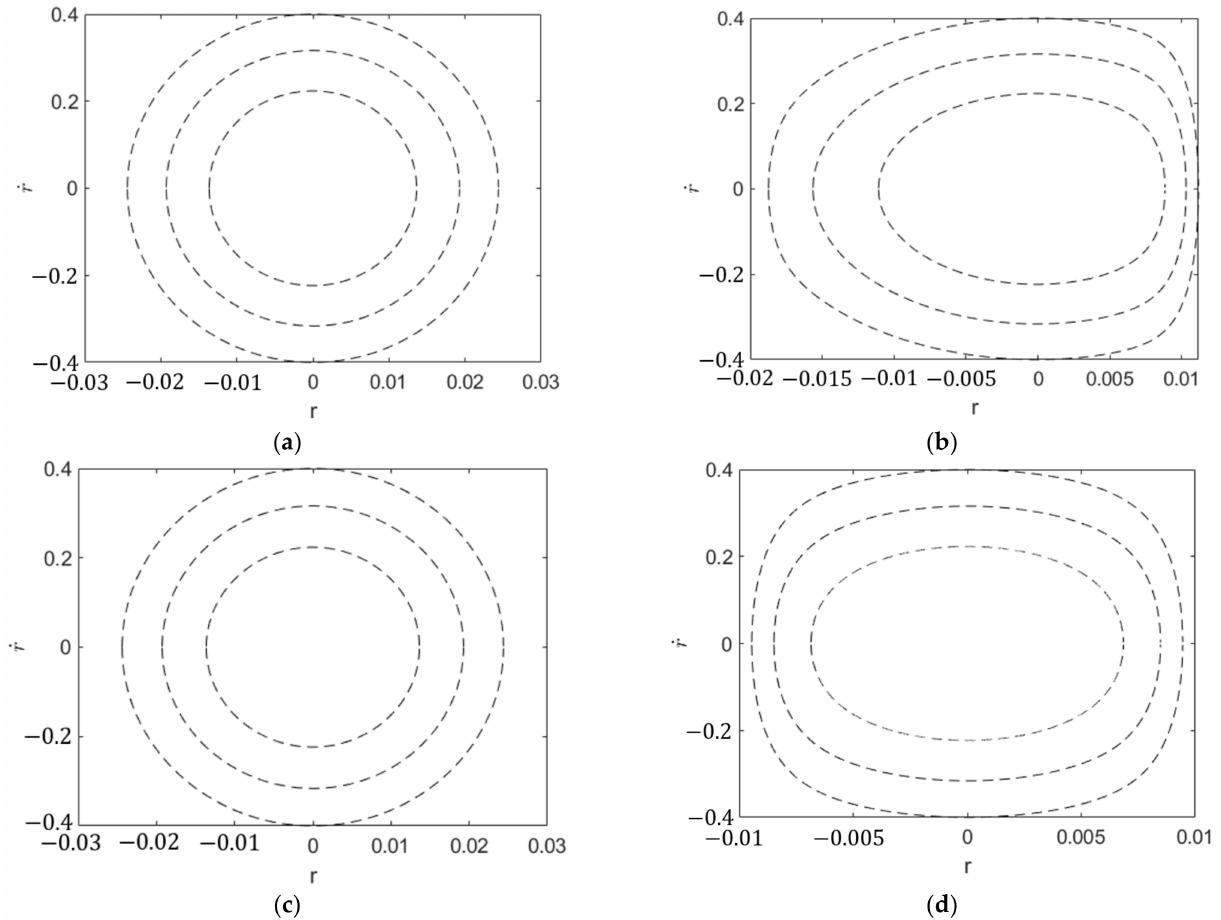
Figure 12. Potential energy for the repulsive configurations with ( a ) single magnet and ( b ) double magnets.